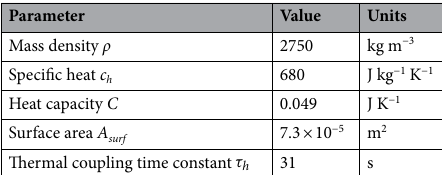
Table 2. The thermal parameters of GAYY-3 glass.